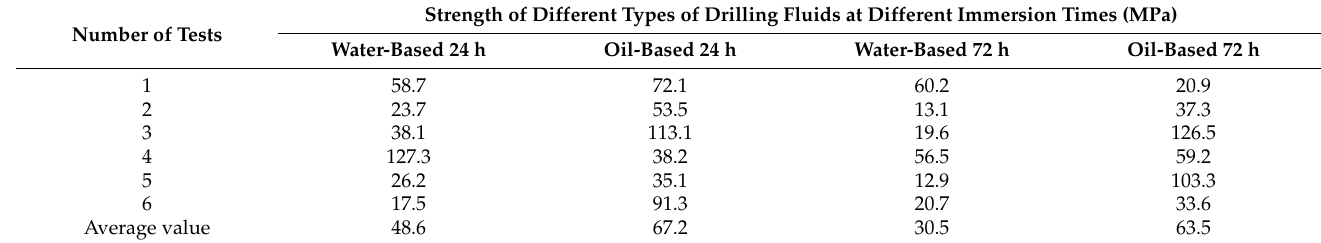
Table 2. Strength test results of mud shale in Well B after soaking in